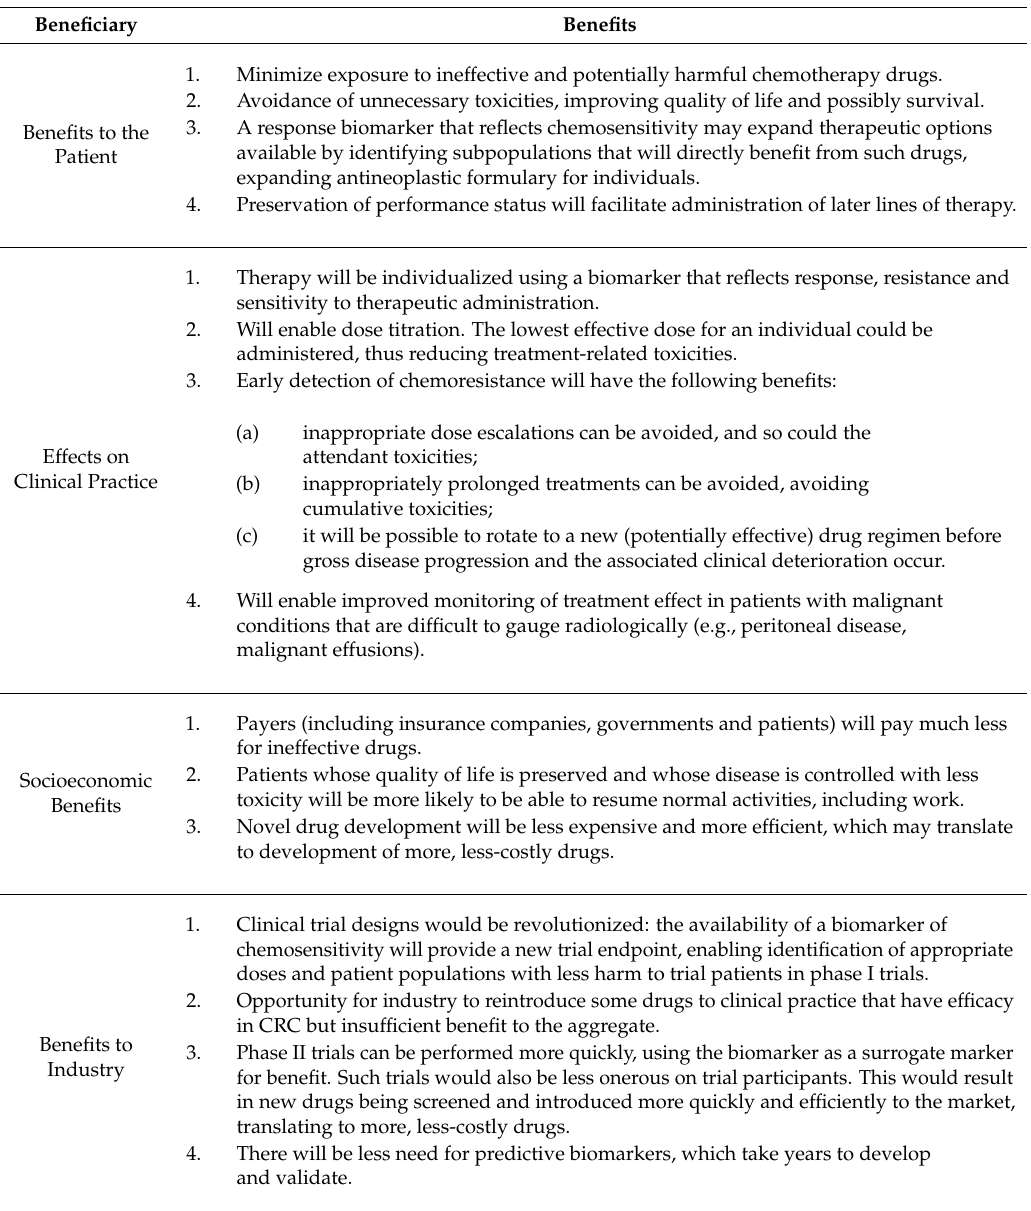
Table 1. Potential benefits of a response biomarker for antineoplastic